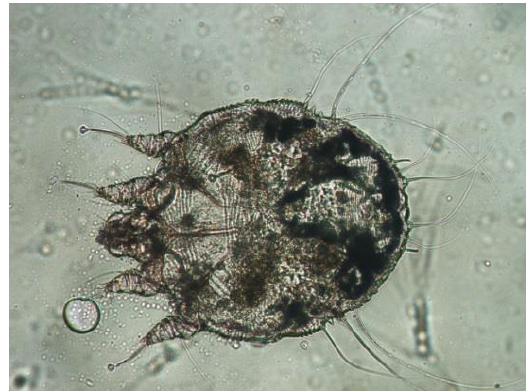
Figure 2. Sarcoptes scabiei visualized under a light microscope.